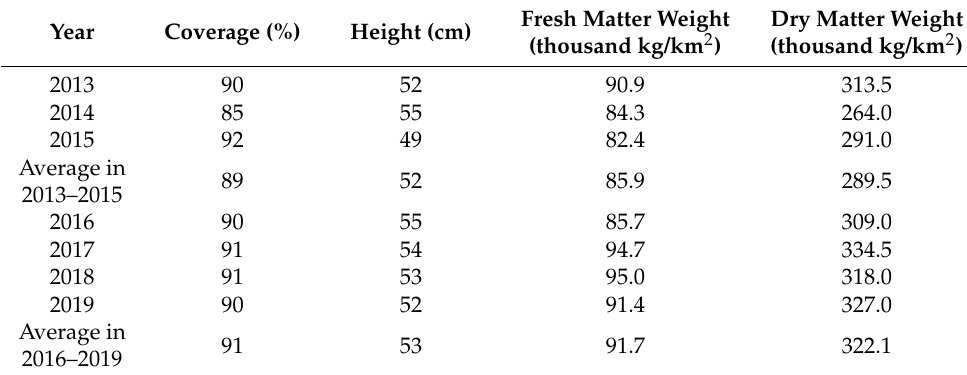
Figure 7. Interannual variation in vegetation coverage and grass yield. Table 4. Statistics of grass yield.